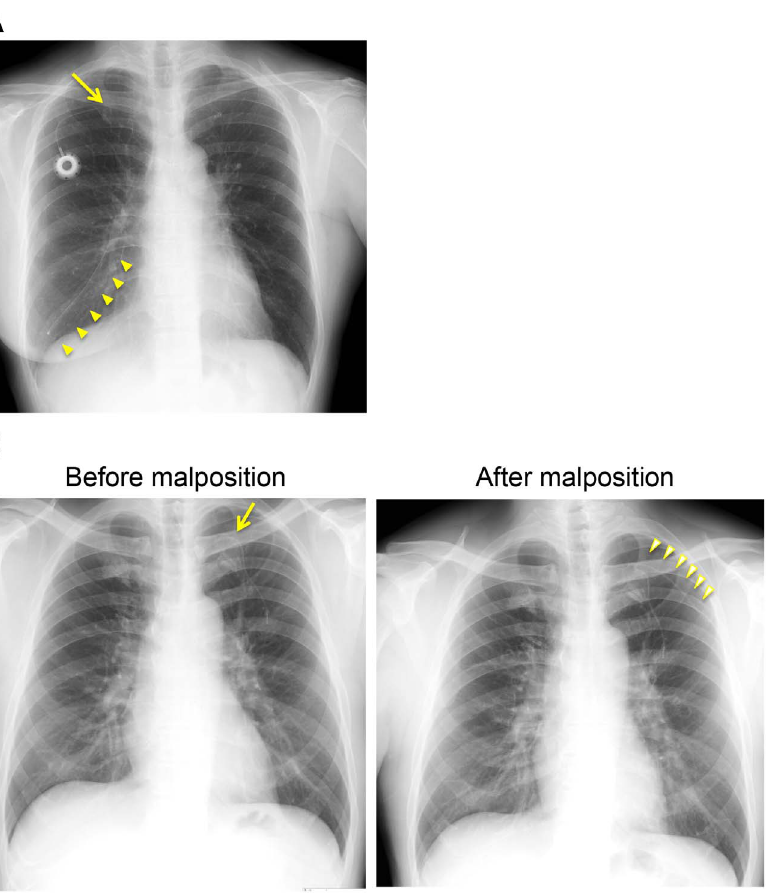
Figure 7. Images of postprocedural complications that could be prevented with an upper arm CV port. ( A ) Catheter pinch-off syndrome and fracture. Arrow indicates a ‘‘pinched-off’’ and fractured site of a catheter. Arrowheads indicate the fractured distal catheter fragments that had migrated into the pulmonary artery through the heart. ( B ) Catheter inversion. Left panel, Arrow indicates a normal catheter placed centrally. Note that there is a sweep turning point at this puncture site that may cause tension derived from an elastic restoring force. Right panel, Arrowheads indicate the peripherally inverted distal portion of a catheter for the same case.